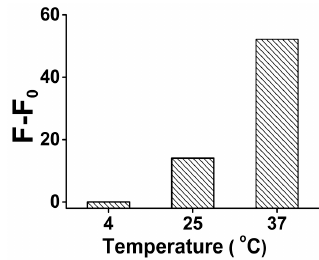
Figure 2. The optimization result of the analysis temperature for Pb 2+ sensing in the presence of 1 μ M Pb 2+ . Original data for the optimization result of the analysis temperature shown in Figure S4.